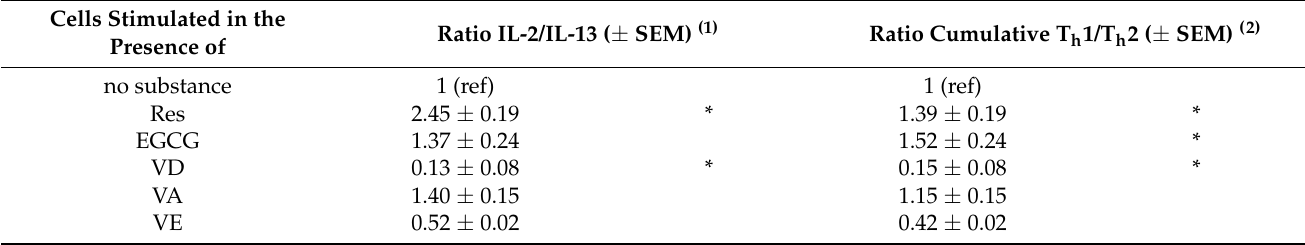
Table 2. Substances induced shift in the T h 1 and T h 2 prototype interleukin secretion. Cells Stimulated in